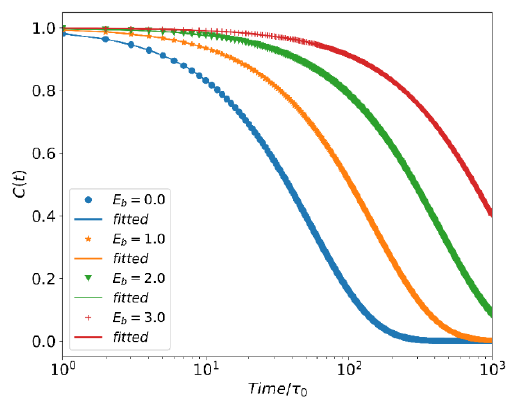
Figure 1. Reversible bond autocorrelation function 𝐶 𝑏 (𝑡) for different values of bonding activation barrier 𝐸 𝐵 .